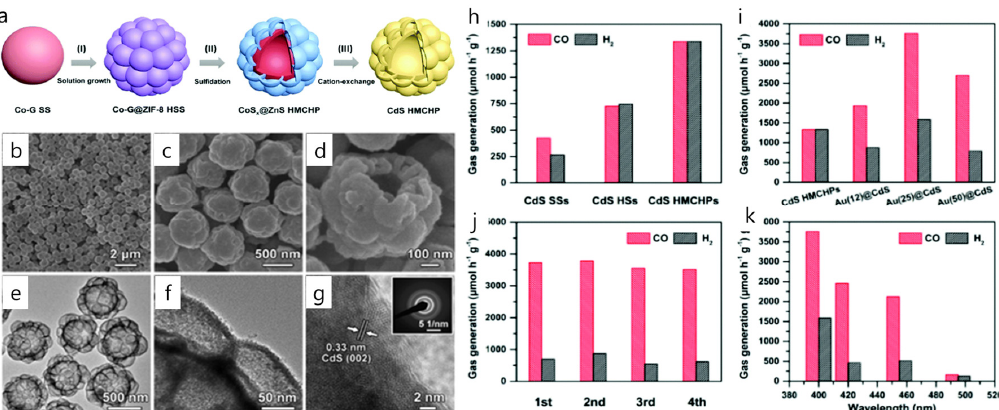
Figure 2. (a ‐ d) Scanning electron microscope (SEM) and (e ‐ f) transmission electron microscope (TEM) images of Ru ‐ metal ‐ organic framework (MOF) nanoflowers at different magnifications, reprinted with permission from [91].